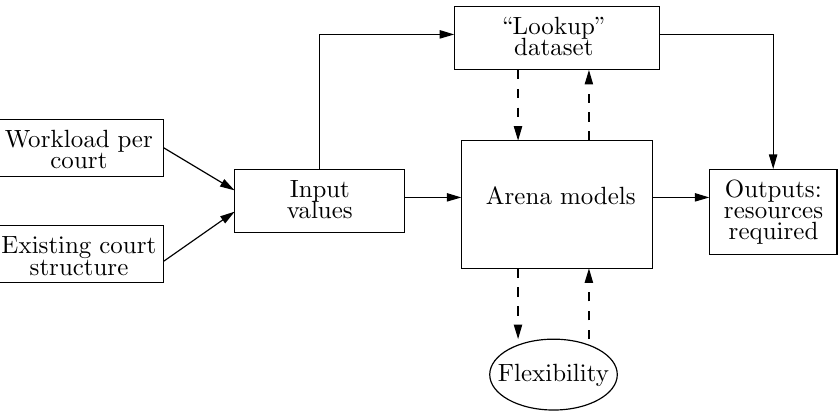
Figure 7: Different linkage paths used to determine